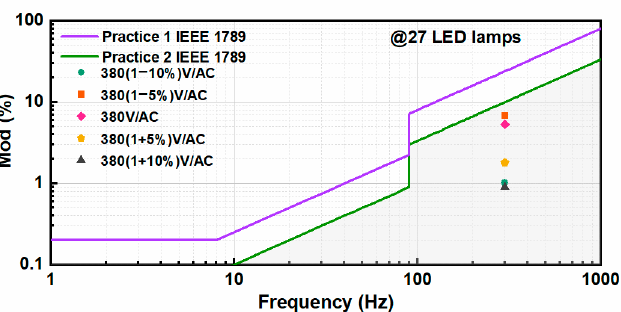
Figure 11. Measured modulation of 27 GaN LED lamps under 380 V ± 10% line